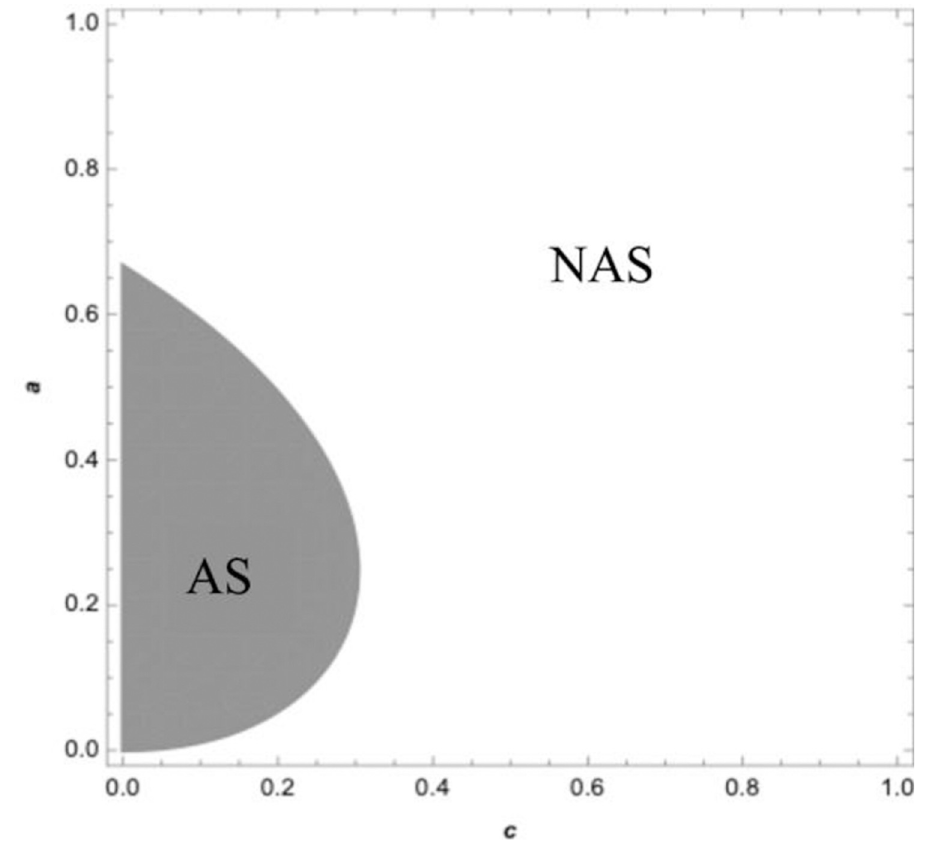
Fig 4. The regions for retailer sell in advance under the RS contract/centralized supply